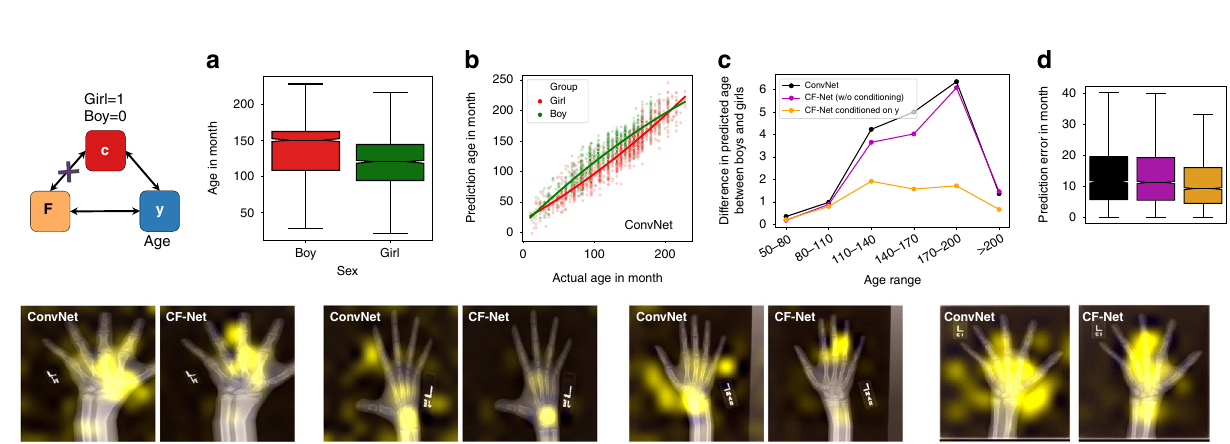
* Denotes signi fi cant higher balanced accuracy than ConvNet by DeLong ’ s test ( p <0.05).